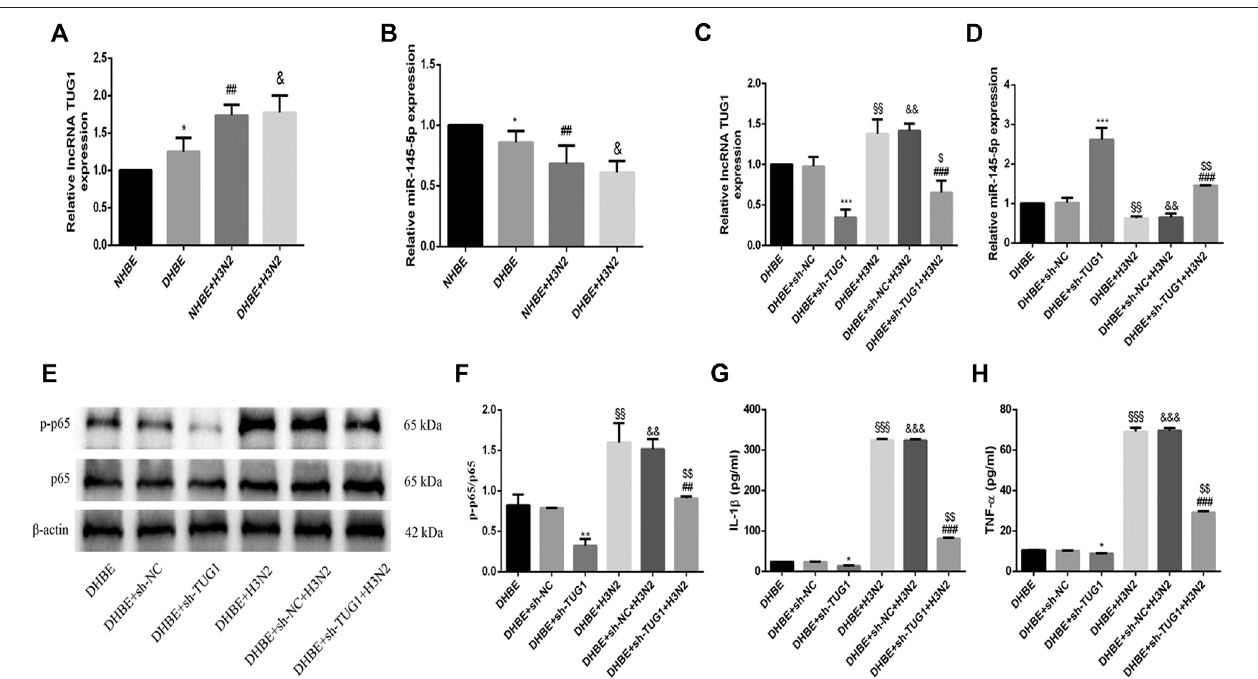
FIGURE 3 | Knockdown of lncRNA TUG1 reduced the IAV induced airway in fl ammation in DHBE. (A,B) The expression of lncRNA TUG1 and miR-145-5p was analyzed in pHBECs with or without IAV infection for 24 h (note: * p ＜ 0.05 as compared to NHBE, ## p ＜ 0.01 as compared to NHBE, & p ＜ 0.05 as compared to DHBE). (C,D) The mRNA levels of lncRNA TUG1 and miR-145-5p were analyzed in DHBE pretreated with or without sh-TUG1. (E,F) The protein expressions of NF - κ Bp65 and phospho-NF - κ Bp65 were analyzed in DHBE pretreated with or without sh-TUG1 by Western blotting. (G,H) The protein expressions of IL-1 β and TNF- α were analyzed in DHBE pretreated with or without sh-TUG1 by ELISA. (* p ＜ 0.05, ** p ＜ 0.01, *** p ＜ 0.001 as compared to DHBE + sh-NC group, ## p ＜ 0.01, ### p ＜ 0.001 as compared to DHBE + H3N2 group, §§ p ＜ 0.01, §§§ p ＜ 0.001 as compared to DHBE group, && p ＜ 0.01, &&& p ＜ 0.001 as compared to DHBE + sh-NC group, $ p ＜